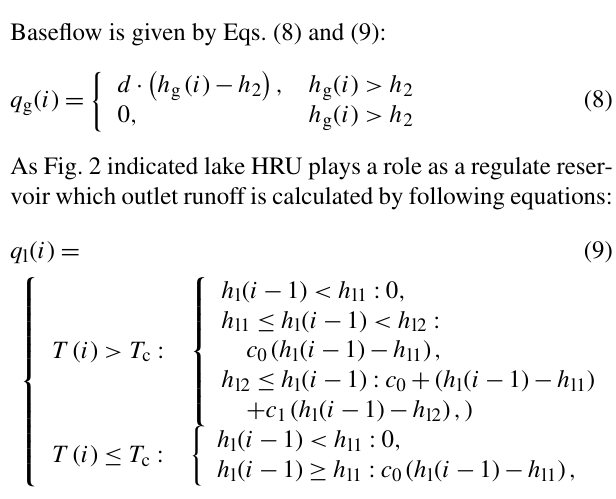
Table 1. Details of selected model and respective output scenarios. Institute ID